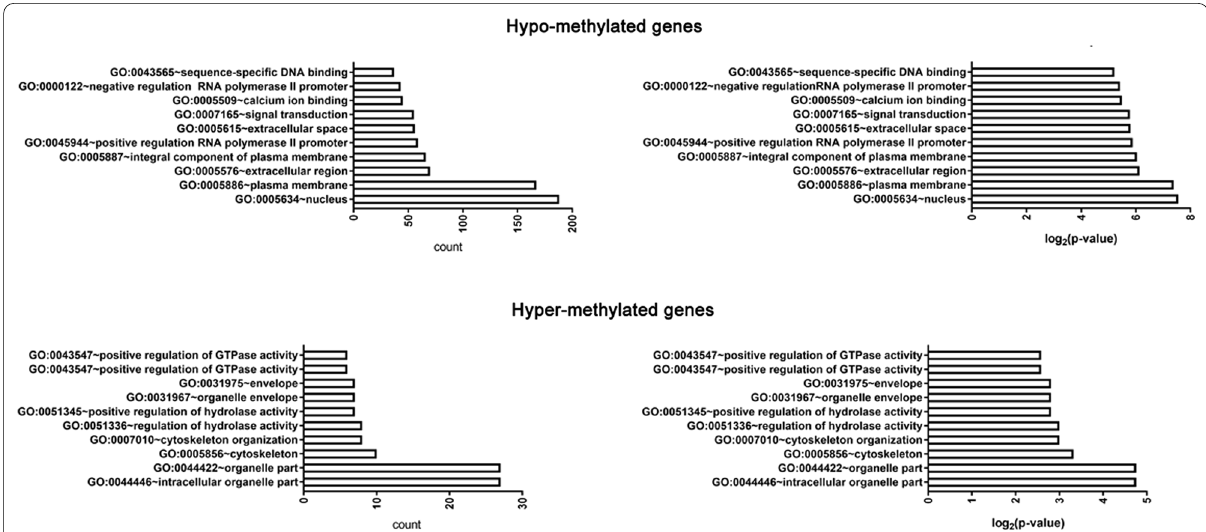
Fig. 2 Top 10 Gene Ontology analysis and significantly enriched GO terms of the candidate DMGs. Up, GO analysis classified the common hypo-methylated DMGs; down, GO analysis classified the common hyper-methylated DMGs,